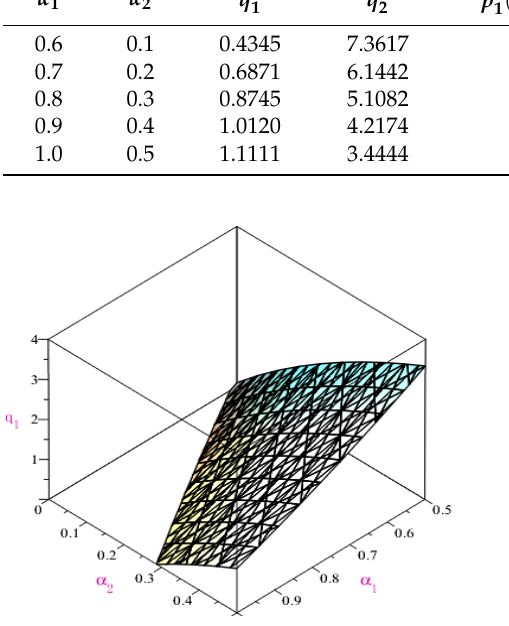
Figure 5. Changes of q ∗